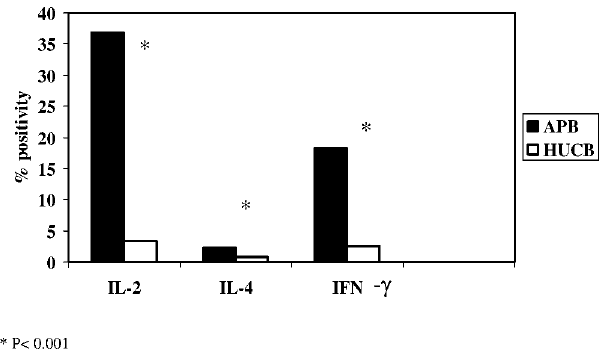
Fig. 2. Cytokine expression on HUCB and APB T lymphocytes. The percentage positivity of eight samples of HUCB and ten APB is shown following PMA/Ionomycin activation. Results are expressed as a percentage of CD3 + lymphocytes.